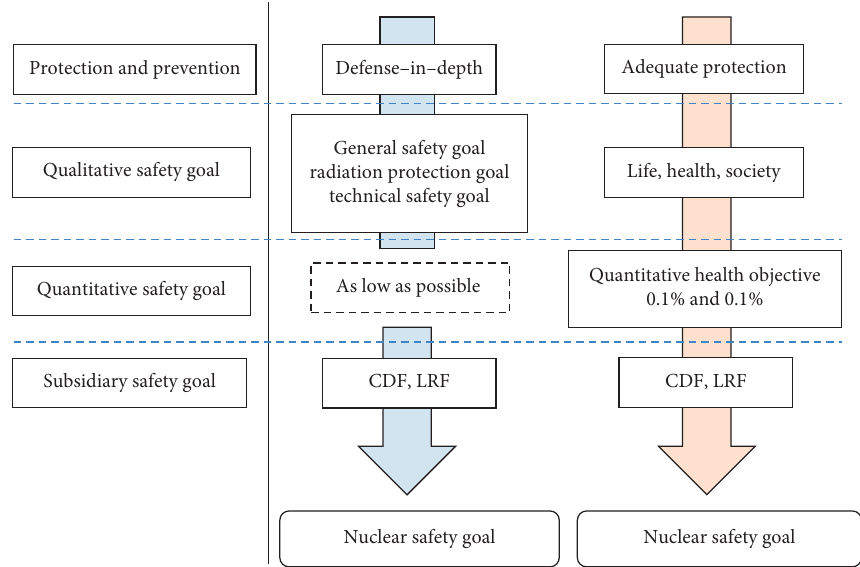
Figure 1: Nuclear safety goal systems in China and the United